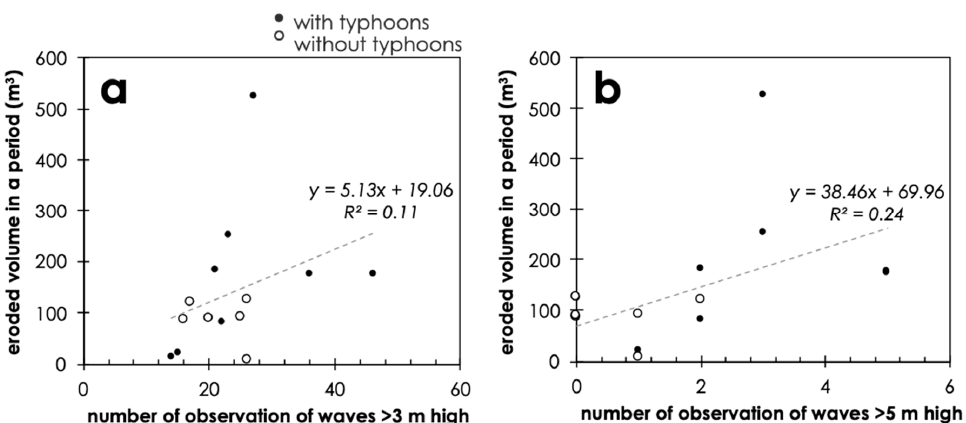
Figure 8. Relationships between the frequency of the high tidal waves and the eroded volume of the island. ( a ) Occurrences of offshore waves higher than 3 m. ( b ) Occurrences of offshore waves higher than 5 m. The black dots indicate the periods potentially affected by typhoons passing near the study area and the white dots indicate those without typhoon attacks.